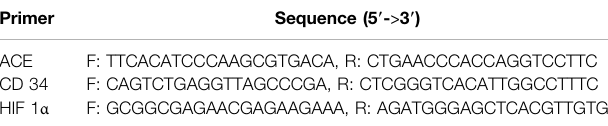
TABLE 4 | Sequence of primers.